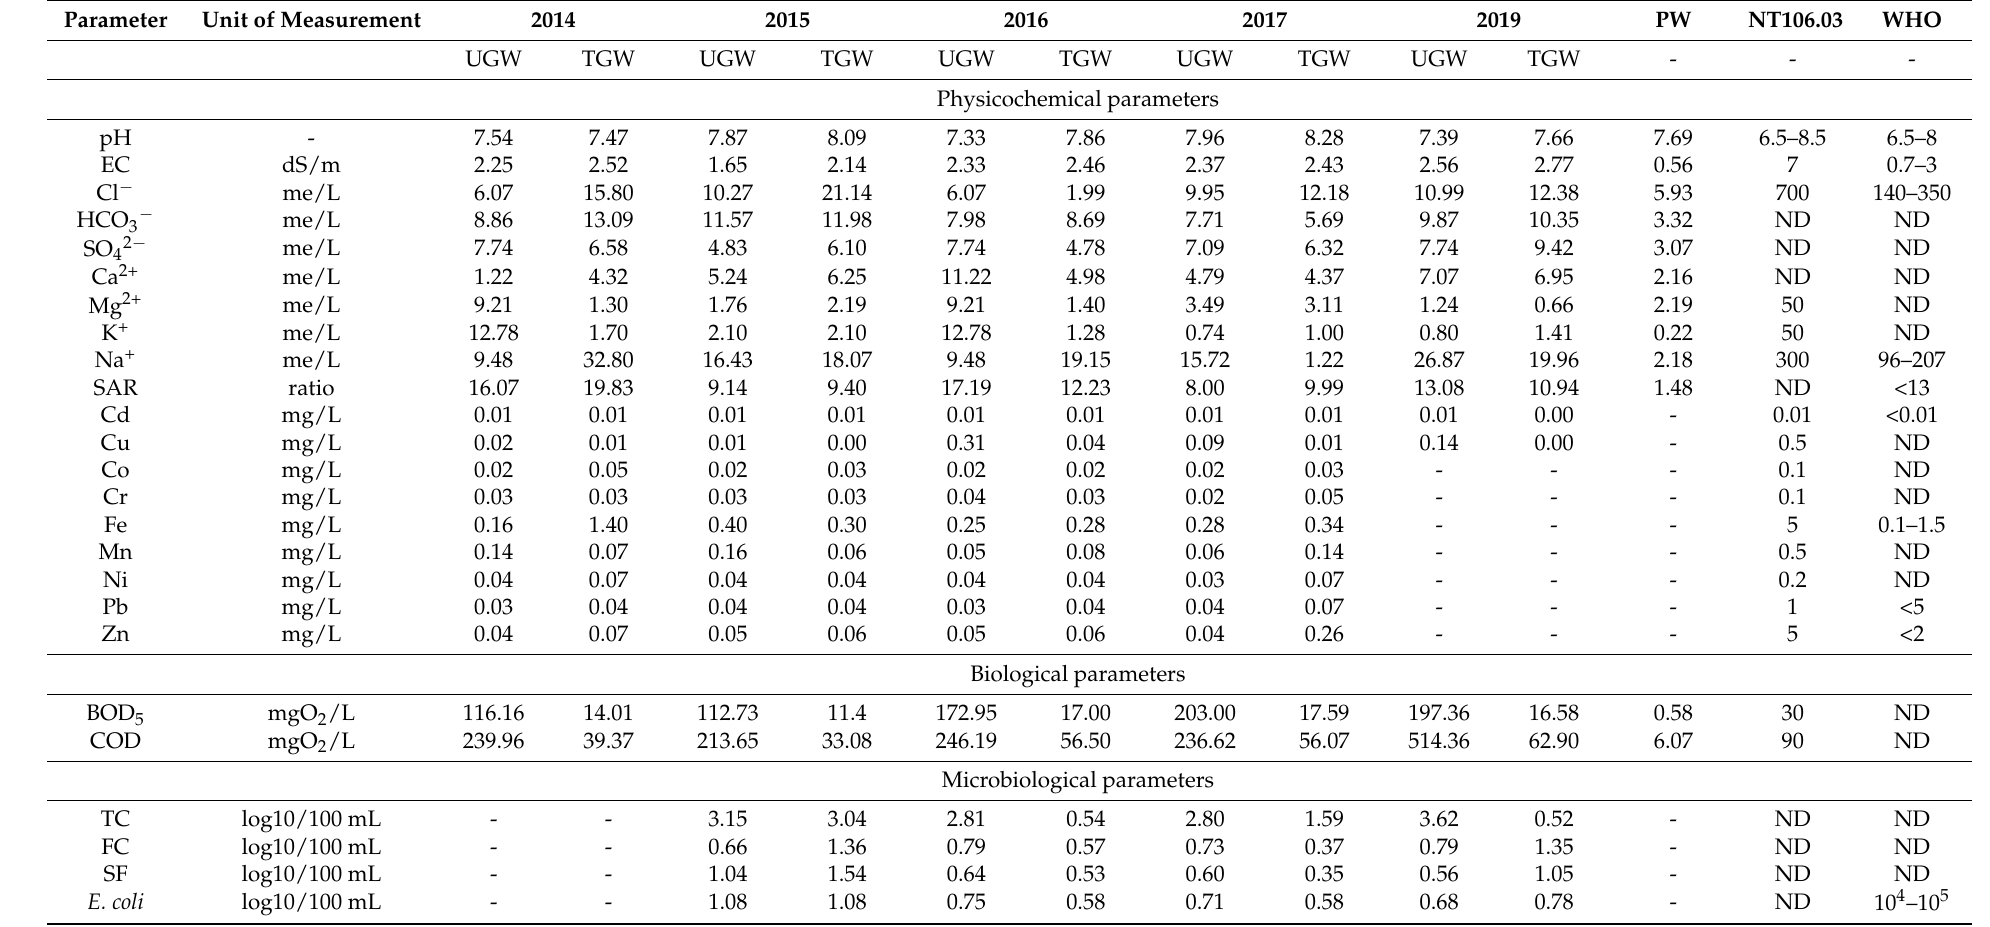
Table 1. Physicochemical and microbiological characteristics of the